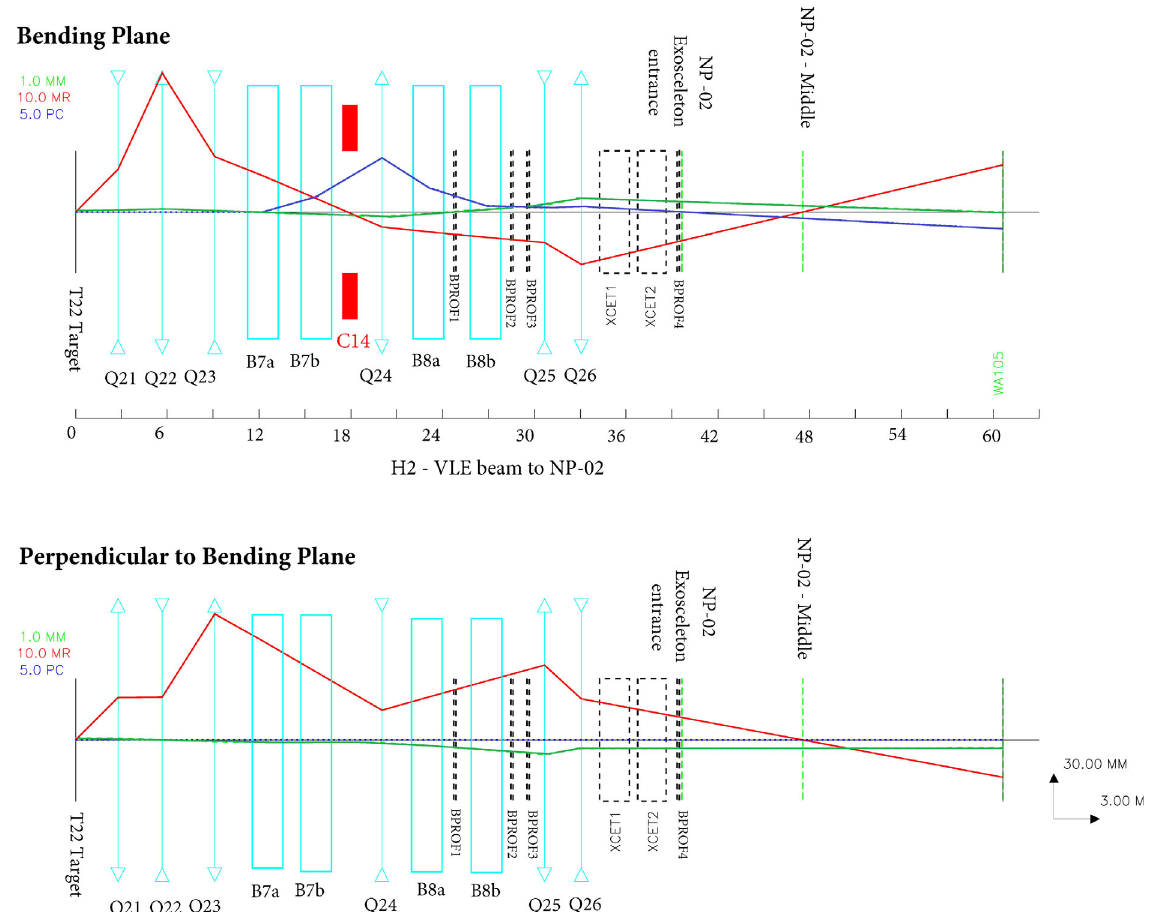
FIG. 7. Optics diagram for the H2-VLE beam line. The red line corresponds to the sinelike ray (particles emerging at 10 mrad from the target), the blue line represents the dispersive ray (at 5%) and the green line the magnification term (corresponding to 1 mm at the